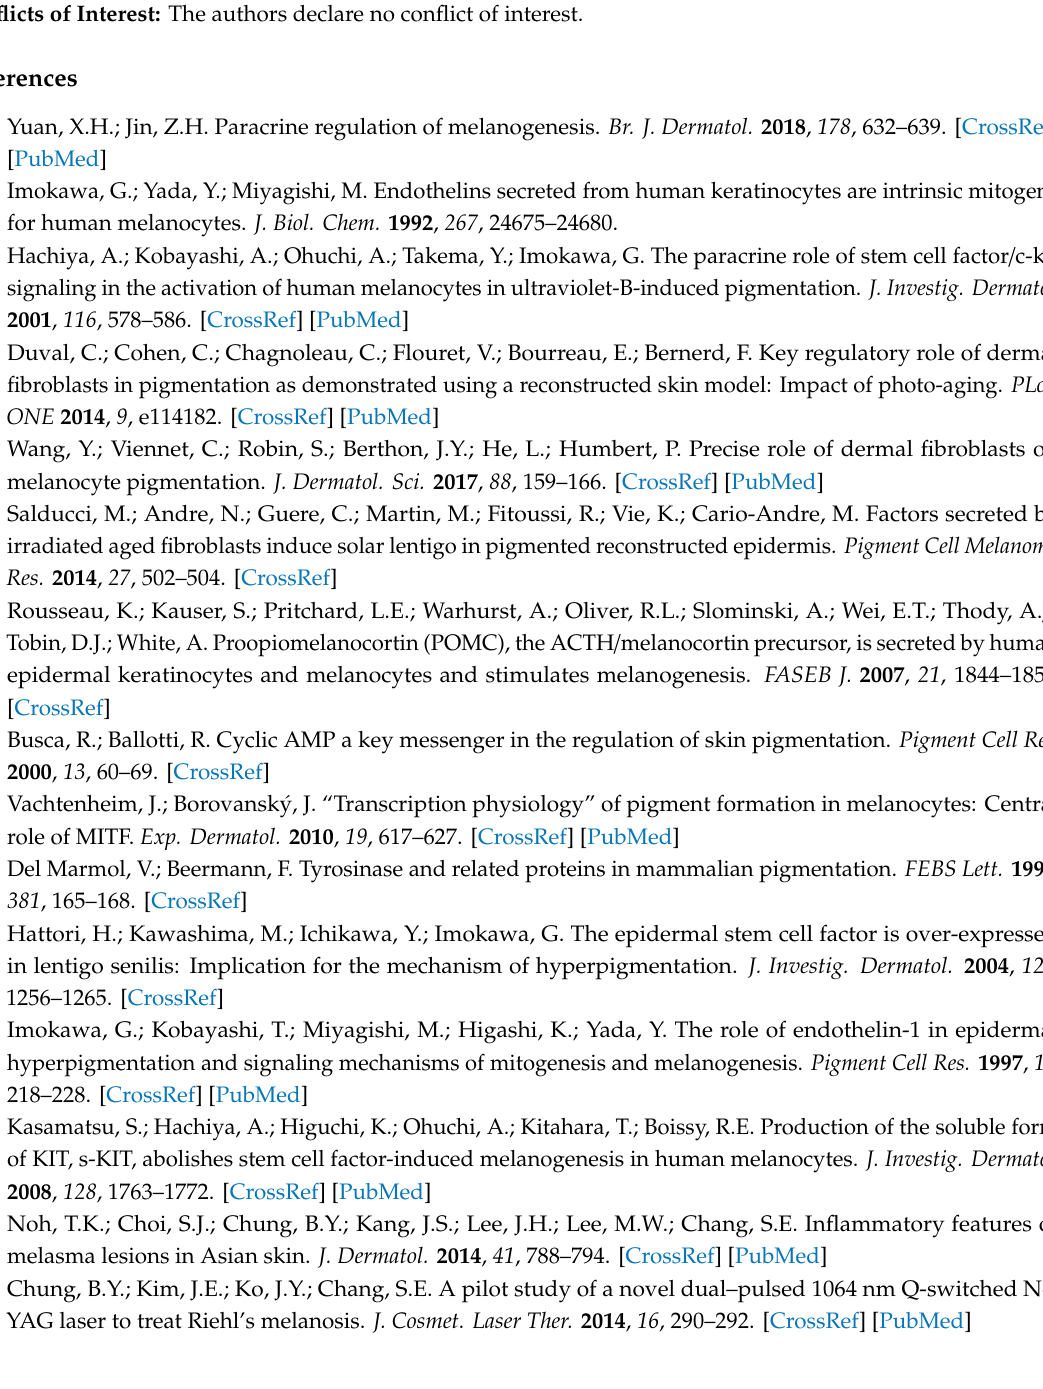
Table S1: Clinical features of patients with Riehl’s melanosis who were included in next generation sequencing and quantitative PCR, Figure S1: The standard curve with synthetic melanin, Figure S2: Phase contrast images of keratinocyte-melanocyte coculture for 5